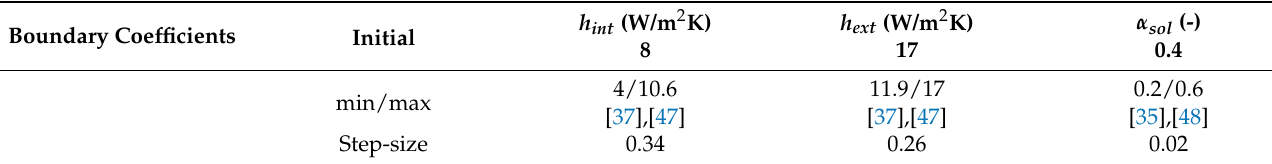
Table 3. Range of variation of boundary